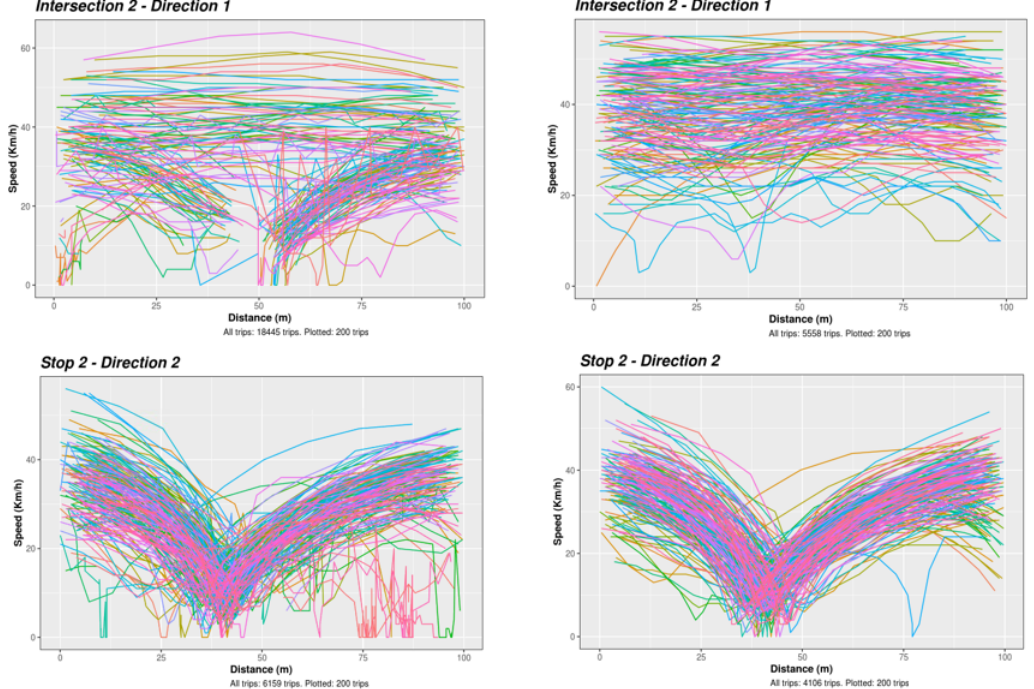
Figure 5. An example of speed profiles of trips on the window at an NS ( top ) and an ST ( bottom ), before ( left ) and after ( right ) filtering trips and fixing GPS